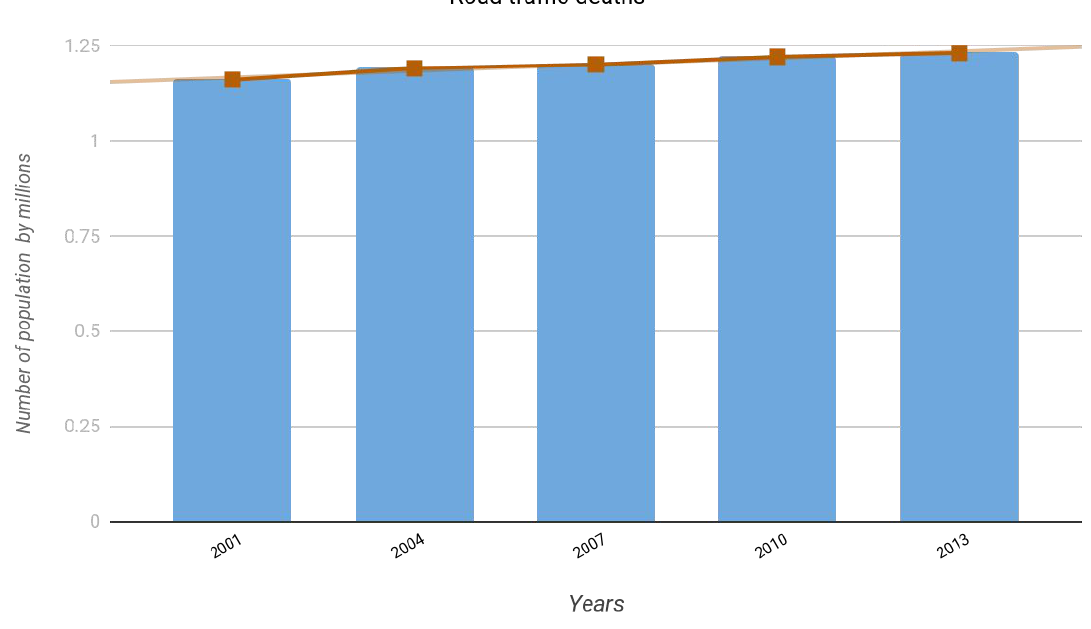
Figure 1. Road deaths on the world’s—World Health Organization (WHO) report 2015 [1].